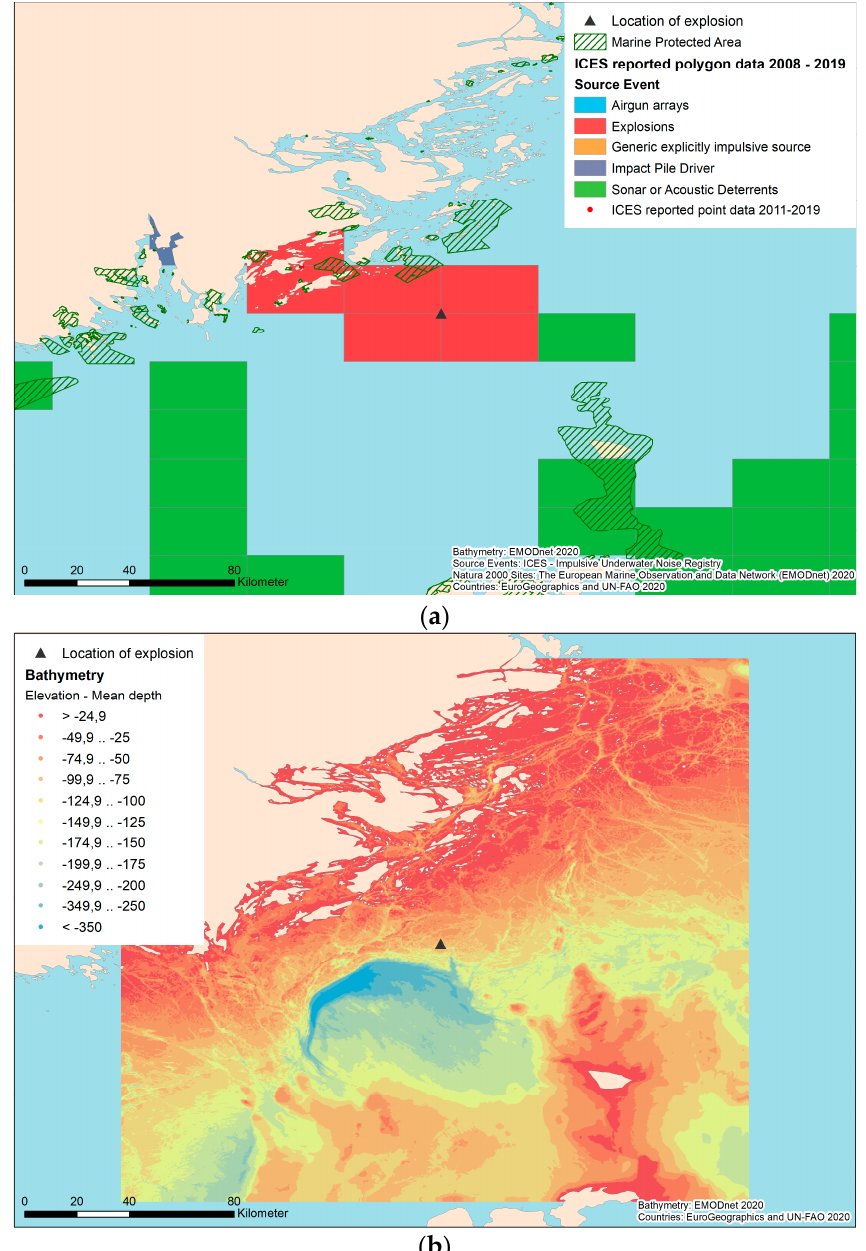
Figure 7. ( a ) Map of the study region including the Huvudskär Natura 2000 site (hatched area), the explosion events reported to the noise registry (red rectangles) and the explosion location as selected for this study (black triangle); ( b ) bathymetry in the vicinity of the explosion location selected for this study (black